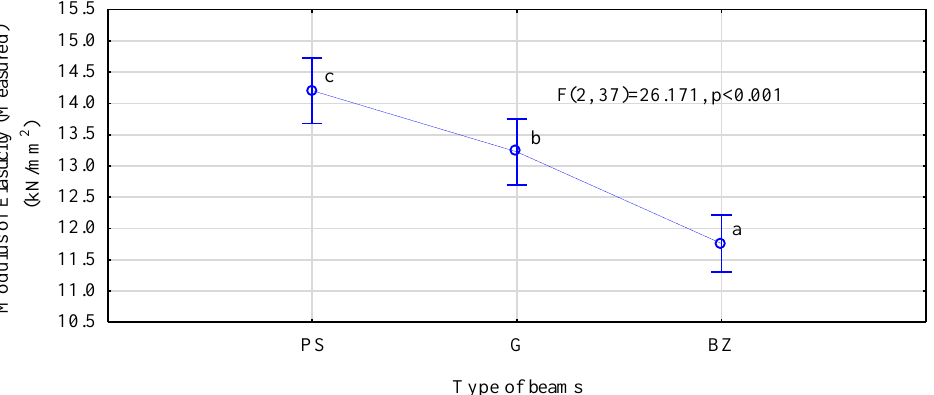
Figure 8. ANOVA for the modulus of elasticity of beams reinforced with rods determined in the bending test (a, b, c letters mark homogenous groups in the HSD Tukey test).